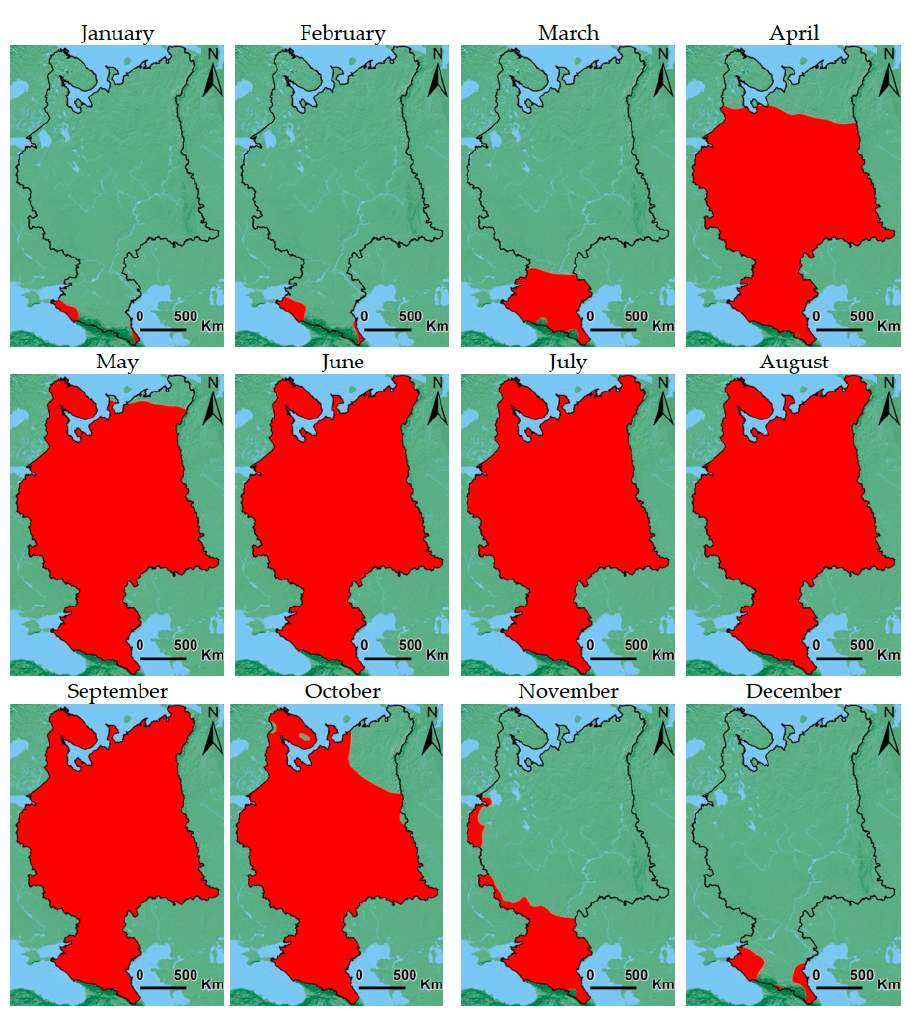
Figure 2. Spatial distribution of the “warm” month in European Russia for assessing rainfall erosion.